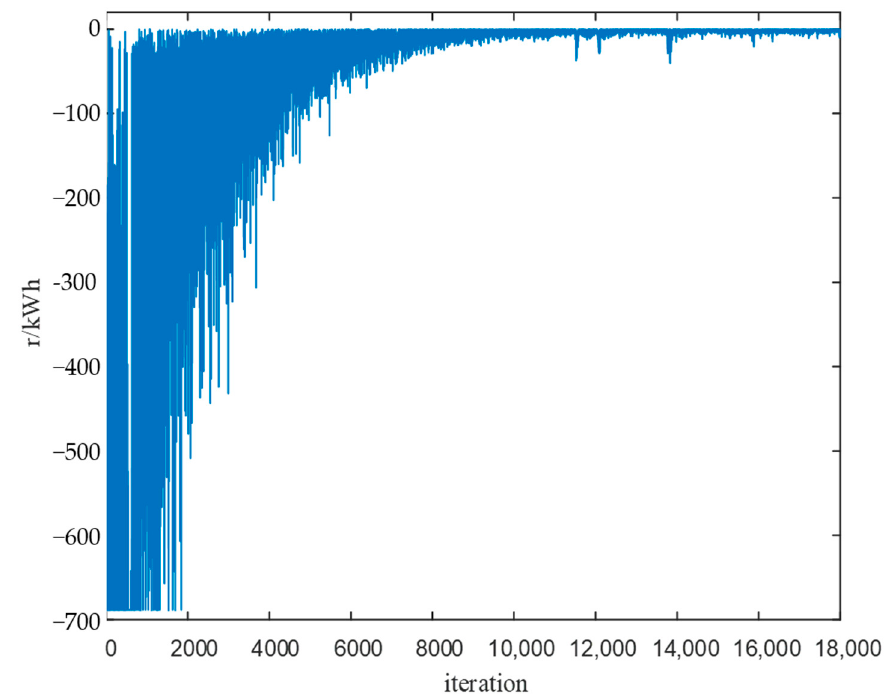
Figure 5. The cumulative rewards during the training process.